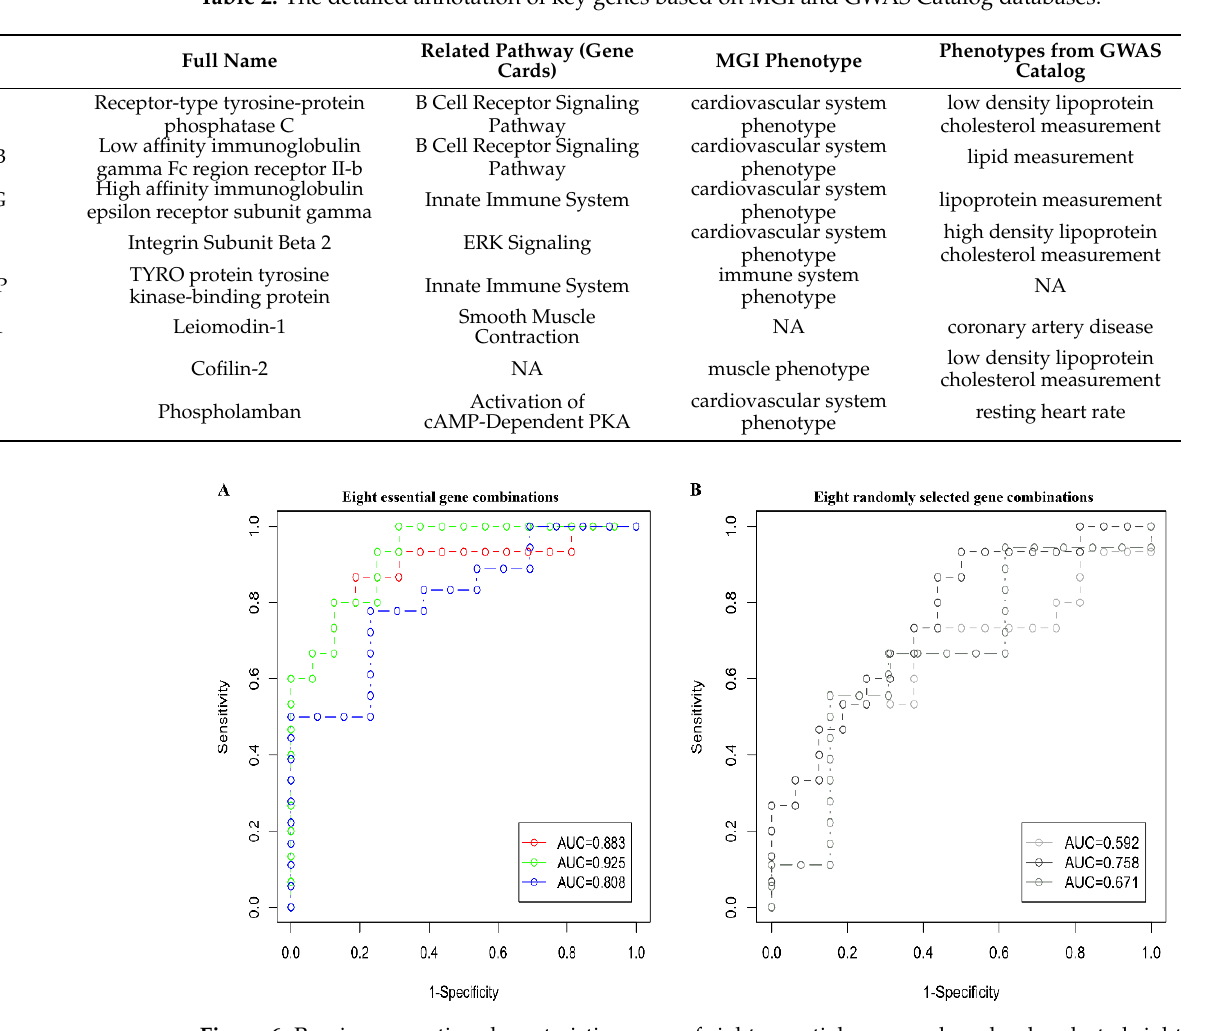
Figure 6. Receiver operating characteristic curves of eight essential genes and randomly selected eight genes. ( A ) The ROC curve of eight essential gene combinations is based on the logistic regression model. ( B ) The ROC curve of eight randomly selected gene combinations is based on the logistic regression model. The x-axis represented the 1-specificity of the negative–positive rate (false positive rate FPR), and the y-axis represented the true positive rate (TRR) sensitivity. Different colors represent the results of 3-fold cross-validation.